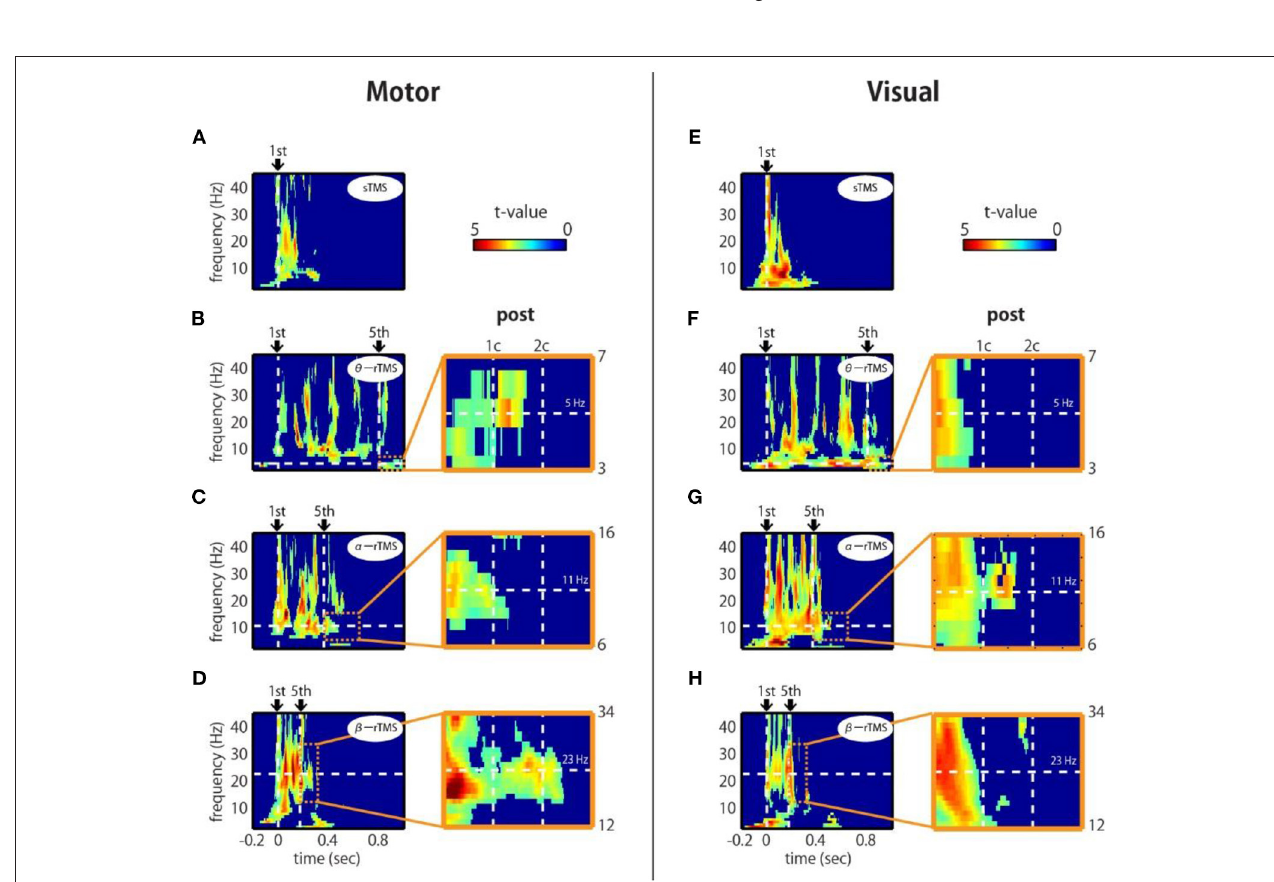
FIGURE 2 | Time-frequency representations of ZPLF at the stimulated areas. Each map with t- values indicates significantly larger ZPLF for motor (C3) stimulation (A–D) and for visual (Oz) stimulation (E–H) than under the sham condition. The vertical lines in the left panels correspond to the first and last stimulation pulses. The horizontal lines indicate the stimulation frequency. Right panels are magnified views of three cycles after the end of rTMS. Vertical lines indicate the post-one cycle (1c) and post-two cycles (2c) for each stimulation frequency.